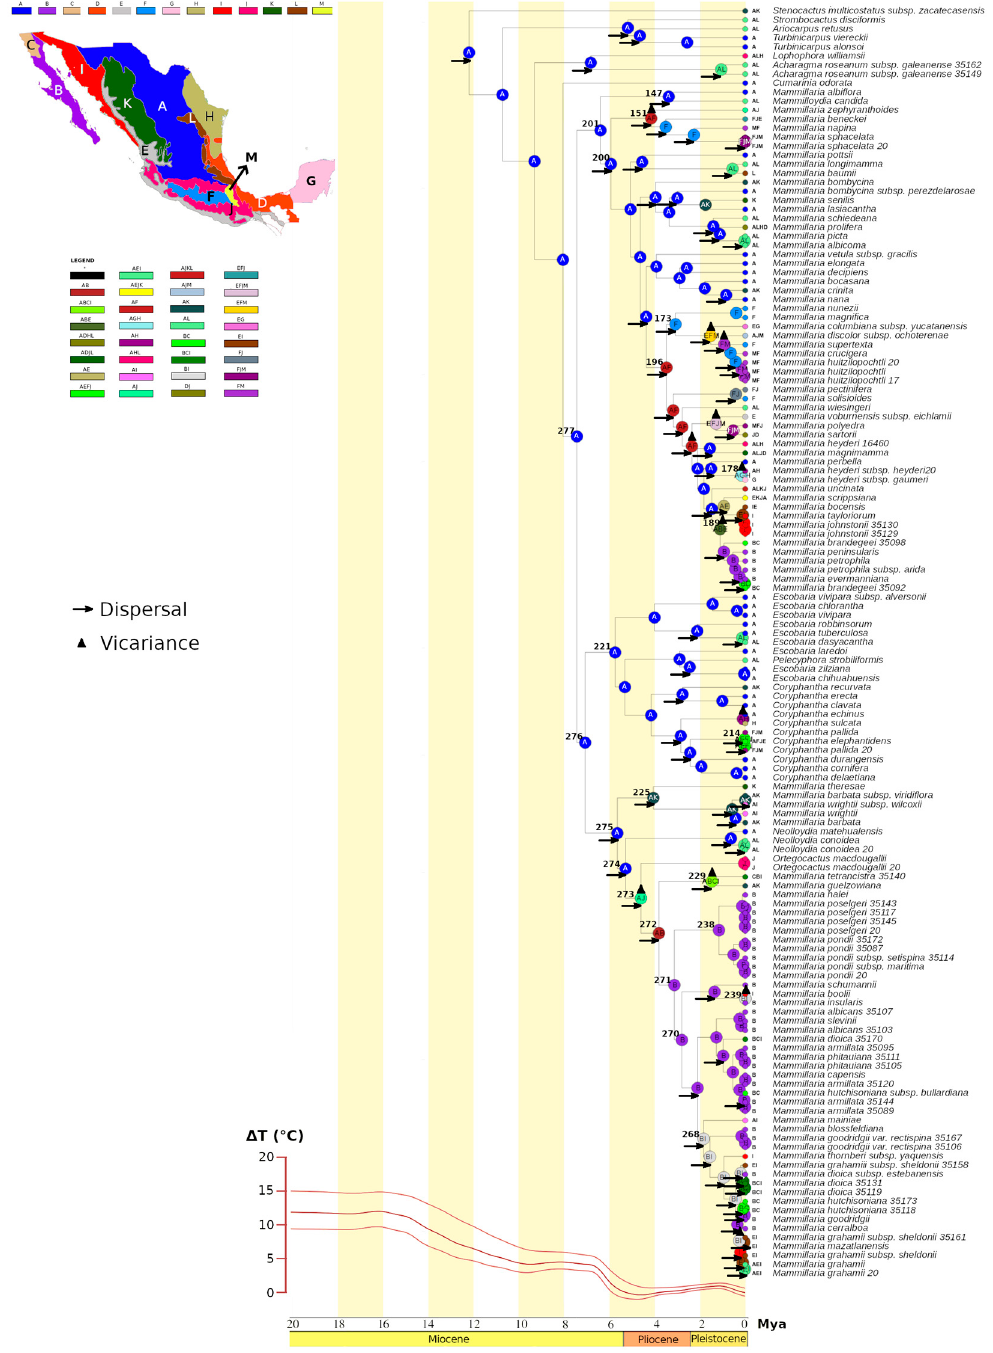
Figure 4. Ancestral geographical distribution of the North American taxa estimated on the chrono- gram. The estimation of the most likely ancestral distribution is represented in a colored circle for each node of the tree. The letters in the map and in the tree corresponded to Baja California (B), Balsas Basin (F), California (C), Gulf of Mexico Coast (D), Mexican Plateau (A), Meridional Serranias (J), Northeast Coastal Plain (H), Northwest Coastal Plain (I), Pacific Coast (E), Sierra Madre Occidental (K), Sierra Madre Oriental (L), Tehuacan Valley (M), and Yucatan Peninsula (G). The nodes of the main evolutionary events were numbered (see the text). The estimated events of dispersal and vicariance are indicated by arrows and triangles, respectively. The letters besides the tips indicate the current geographical distribution of the taxa. At the bottom of the figure were drawn the changes estimations in the global surface air temperature ( Δ T).